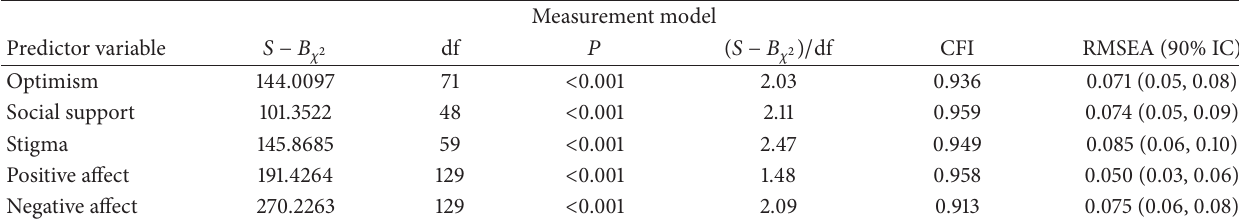
Table 2: Goodness-of-fit test for measurement model.